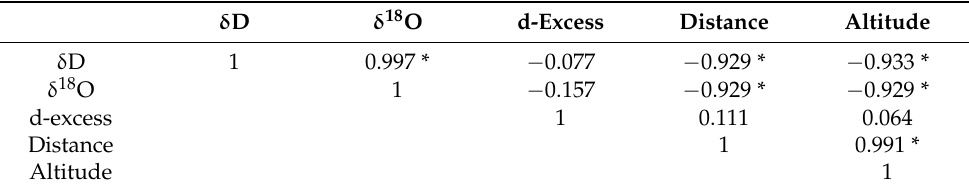
Figure 8. Variations of δ D, δ 18 O, and d-excess of the surface snow samples as a function of distance from the coast. Table 7. Correlation matrix of the stable isotope values of the surface snow samples along with distance from the coast and altitude.